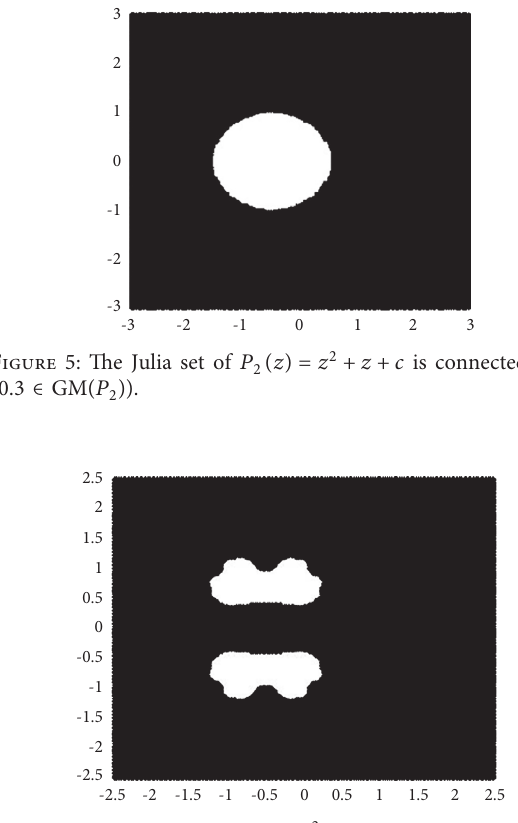
Figure 6: The Julia set of P ( z ) � z 2 + z + c is disconnected where 2 (0.3 ∉ GM( P 2